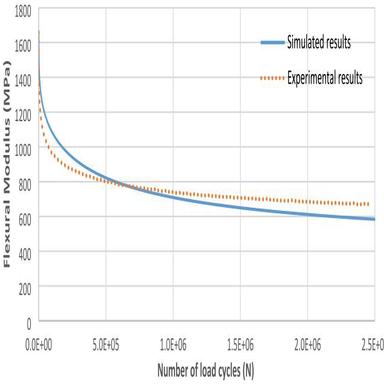
Comparison of simulated and experimental results: strain-controlled fatigue test .